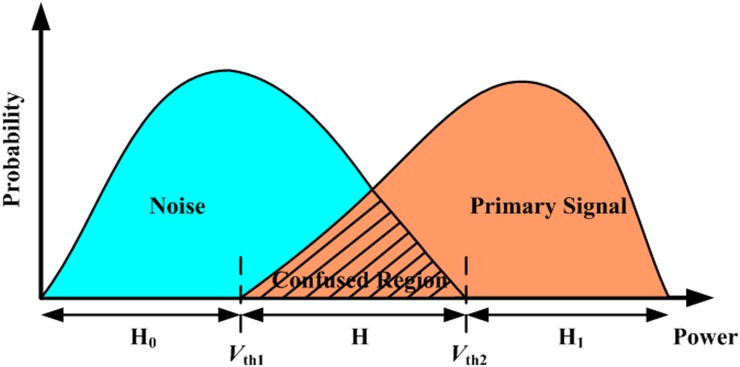
Illustration of energy distribution of PU and noise signals.